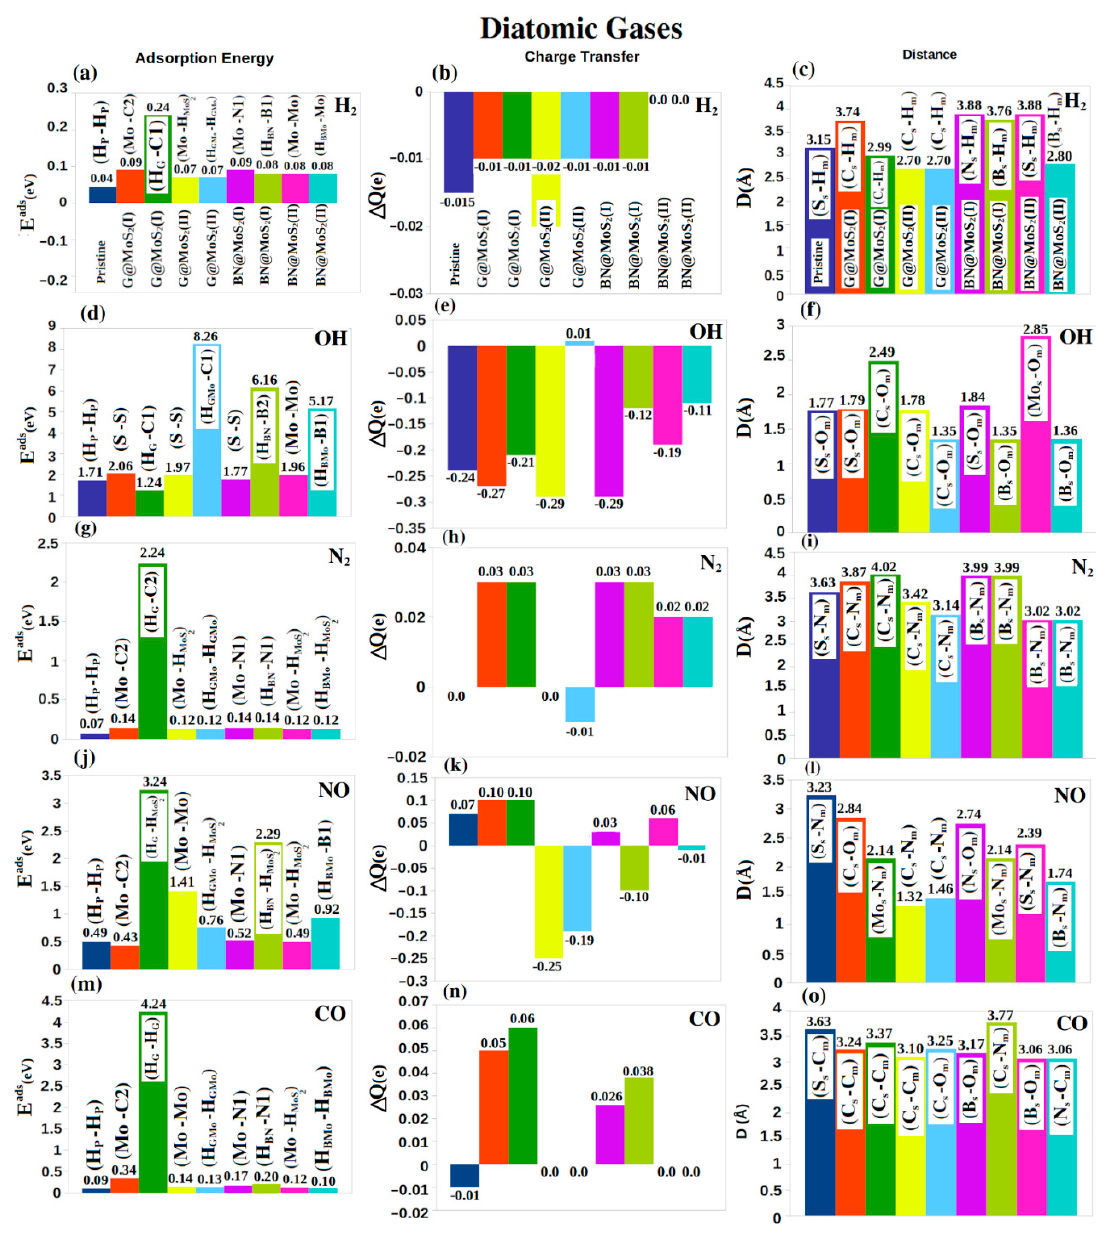
Figure 4. ( a – o ) From left to right, the adsorption energy ( E ad (eV)), charge transfer ( Δ Q (e)) and the and closest distance (D(Å)) between the gas (X m ) and the sheet (X s ) for diatomic gases. From top to bottom H 2 , OH, N 2 , NO, and CO gases are considered. The initial and final positions (Y, Z) of the adsorbed gases before and after optimization are shown in the adsorption energy figures (first col- umn).